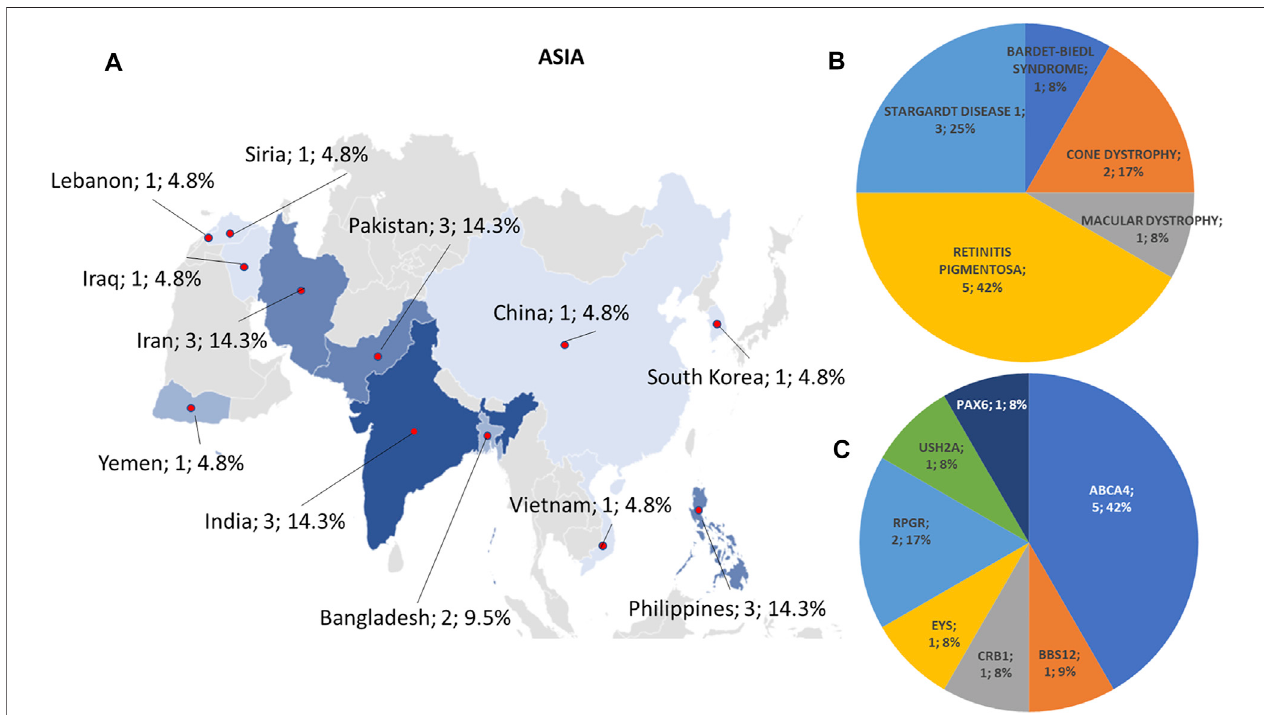
FIGURE3| PhenotypeandgenotypedistributionsinAsiancountries. (A) Themapshowsthenumbersandpercentagesofexaminedpatients.Piechartsshow (B) the phenotypes and (C) genotypes of positive cases.